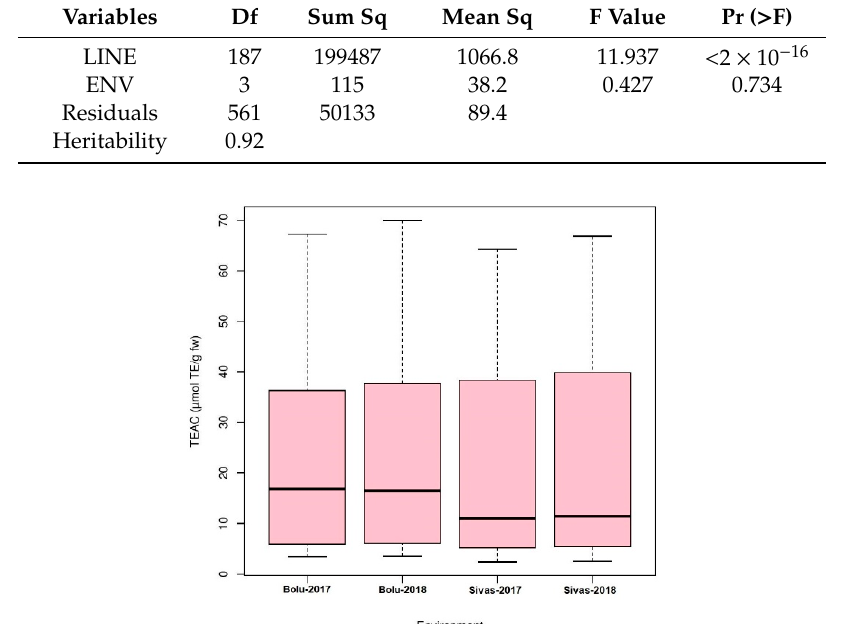
Table 1. Summary of analysis of variance and estimates of heritability in Turkish common bean germplasm.